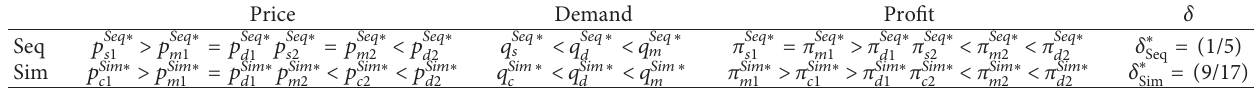
Table 3: Optimal price, demand, and profit of the supplier and retailer in the two-echelon supply chain.